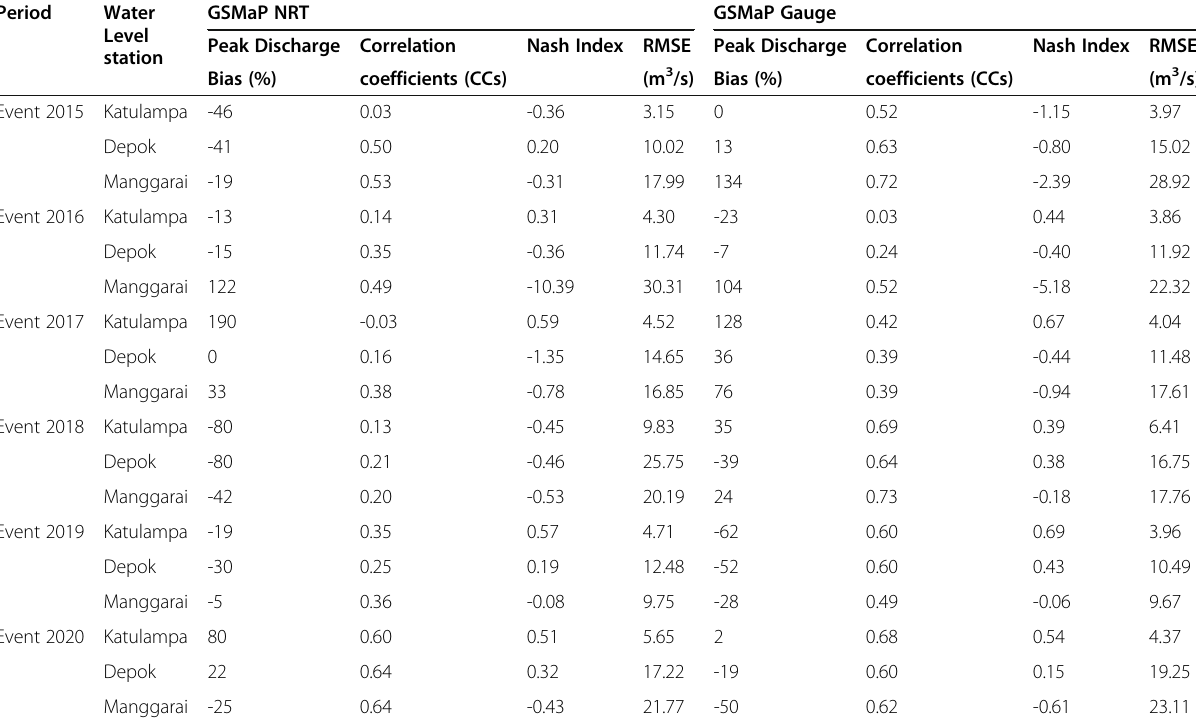
Table 3 Summary of discharge hydrograph comparison